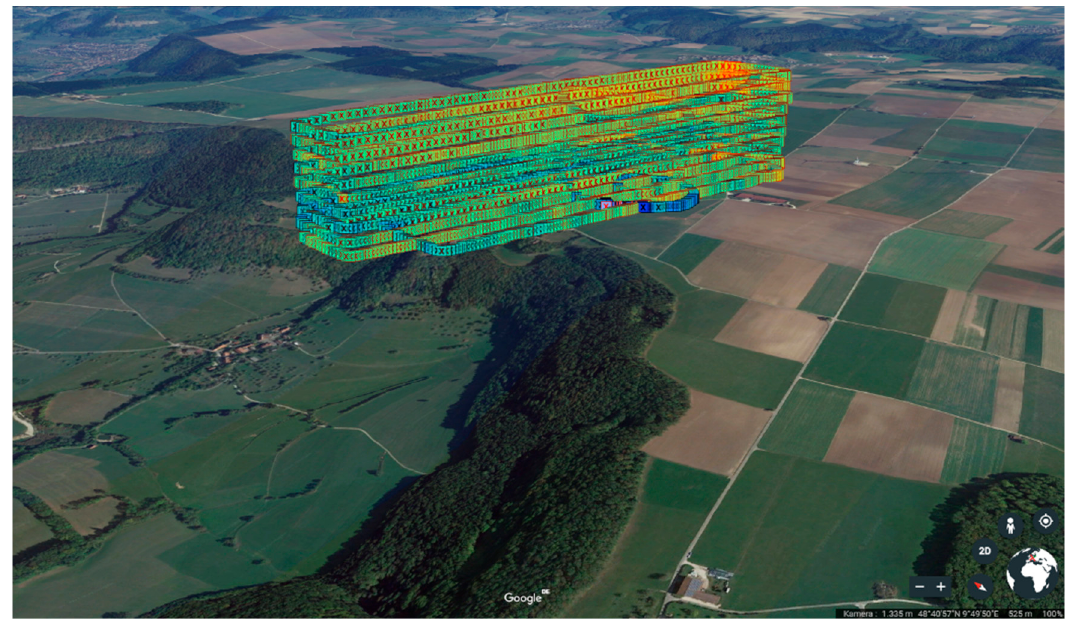
Figure 10. Flight paths (racetracks) performed on the 27 March 2015. The colors indicate the measured horizontal velocity.